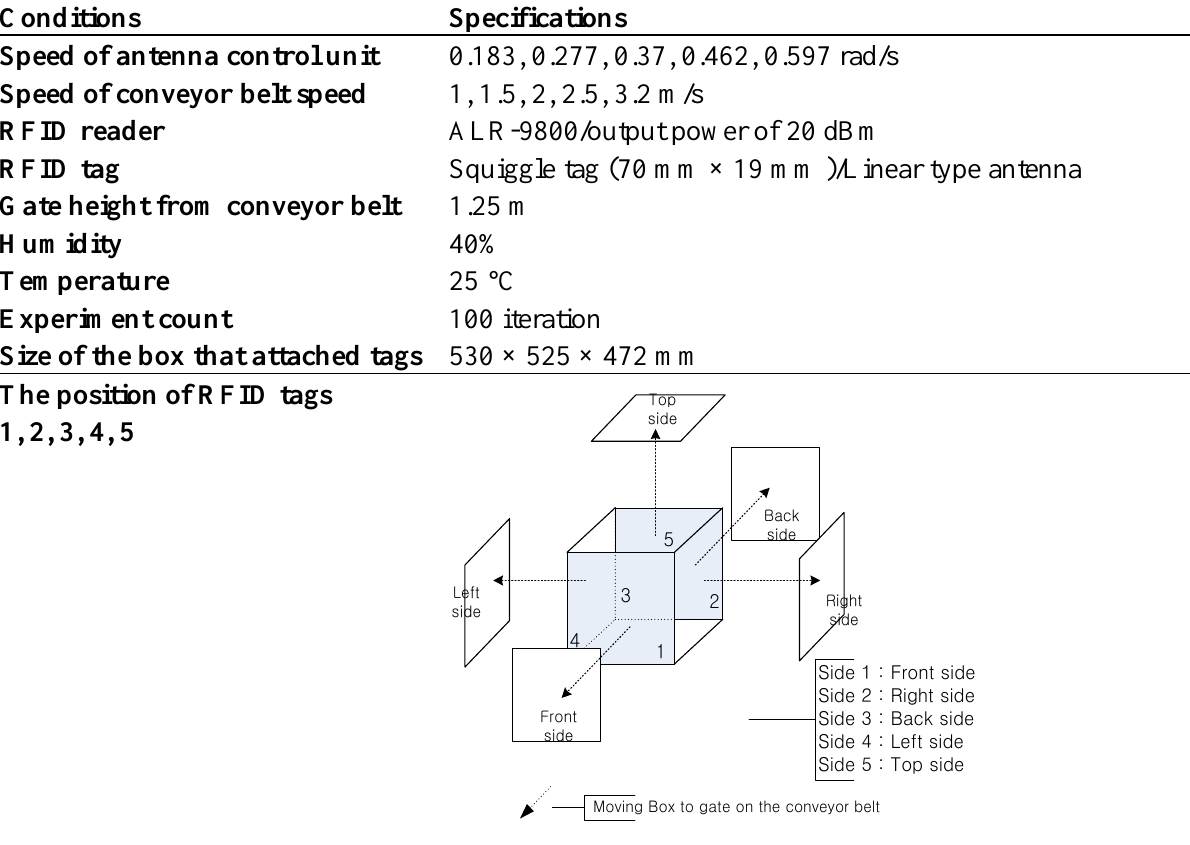
Table 1. Experiment setup (EPCglobal standard